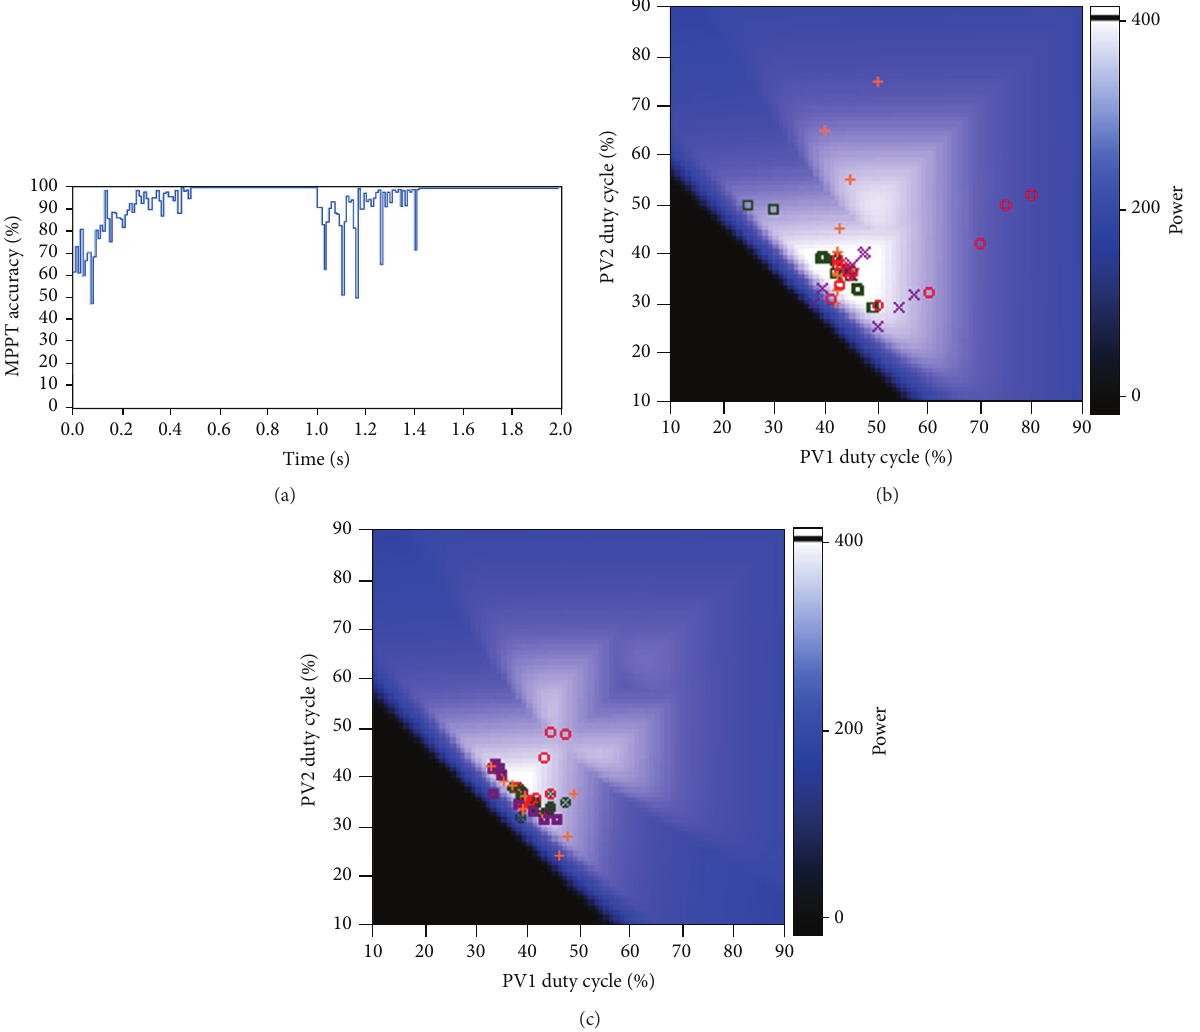
Figure 11: PSO tracking result from Case 2 to Case 4 : (a) MPPT efficiency calculation; (b) agent movement for Case 2 ; (c) agent movement from Case 2 to Case 4 .